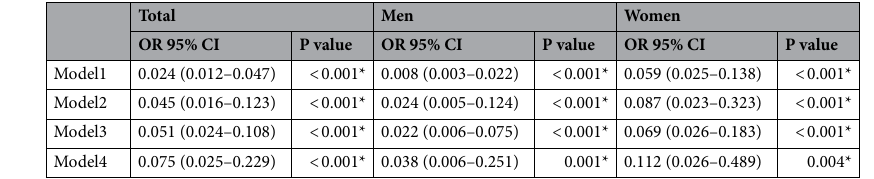
Table 3. Correlation between serum APOB and AF in patients with non-receiving statins. Model 1: crude, no adjustment. Model 2: adjusting for CHD, hypertension, diabetes, β-blockers, CCBs, and ACEI/ARB. Model 3: adjusting for AST, SCr, SUA, ALB, APOA1, and PAB. Model 4: adjusting for all these factors. Abbreviations as in Table 1. *Statistically significant value (P < 0.05).